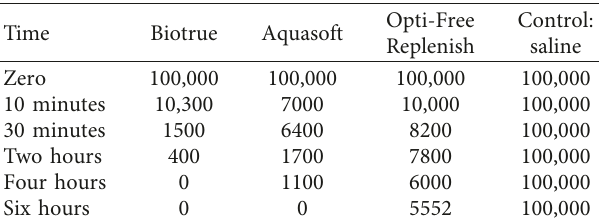
Table 2: Colony counts per solution per time interval for Pseu- domonas aeruginosa .